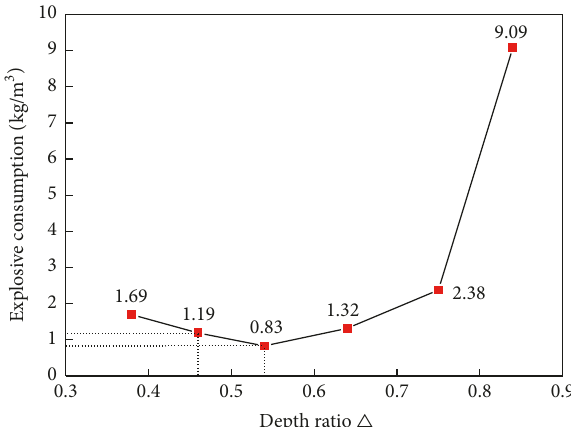
Figure 5: Curve of the consumption of explosives versus the depth ratio.